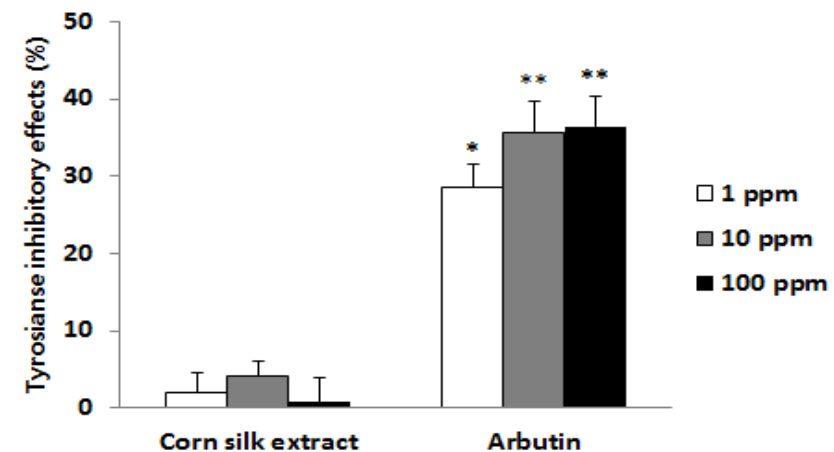
Figure 2. Tyrosinase inhibitory effects.